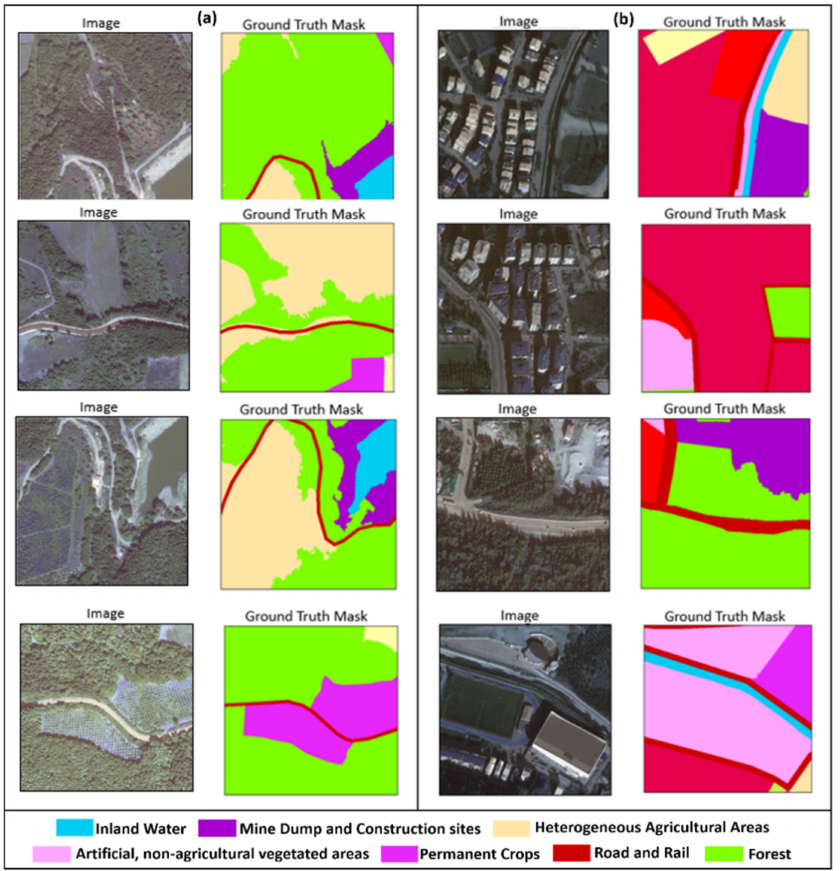
Figure 4. Sample image patches and their corresponding ground truth masks. ( a ) sample patches from the Aksu region, ( b ) sample patches from the Kestel